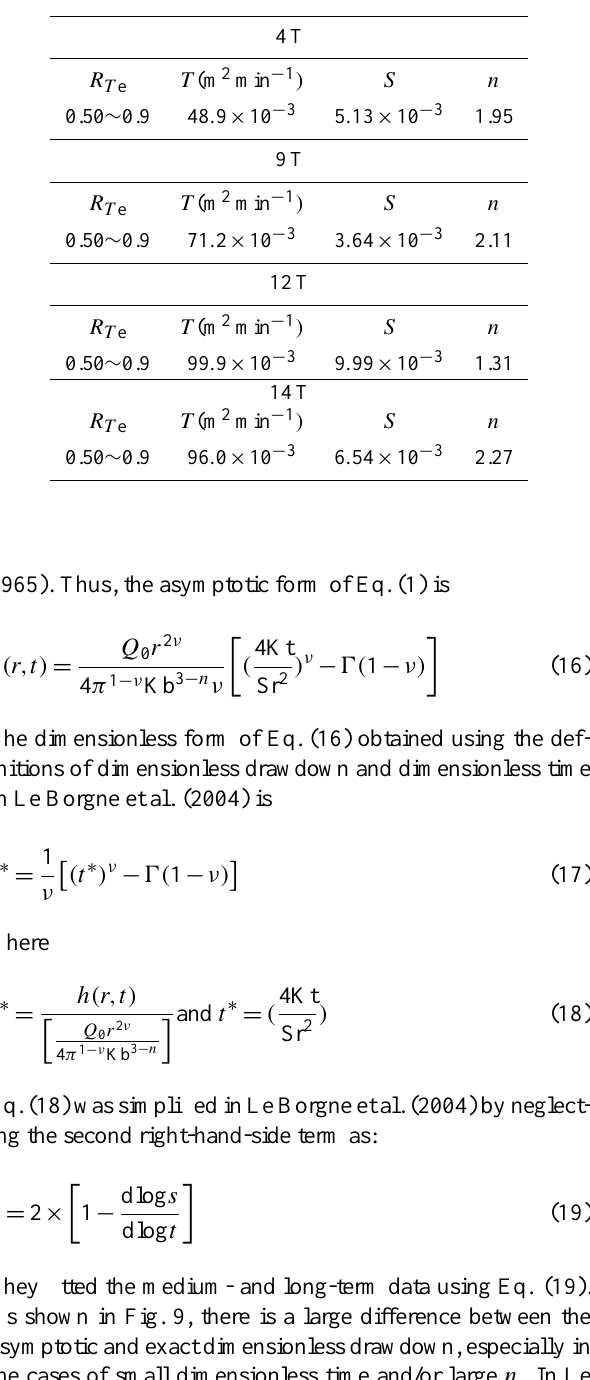
Table 5. The estimated values of hydrogeologic parameters for 4T, 9T, 12T and 14T using various temperature reduction factor R T e varies from 0.50 to 0.90 with an increment of